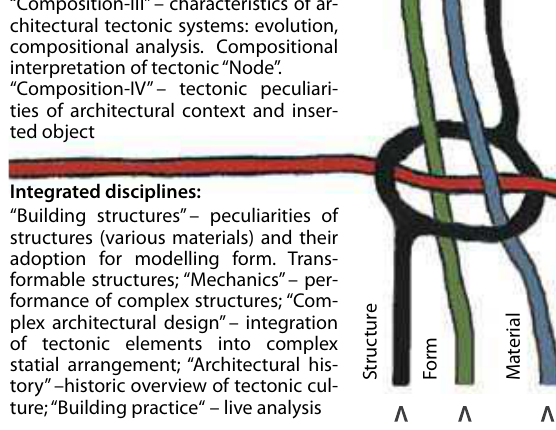
Fig.4. Position of the main tectonic elements in the three- levelled model. Contents and interrelation of Architectural Composition and integrated disciplines at each level. The